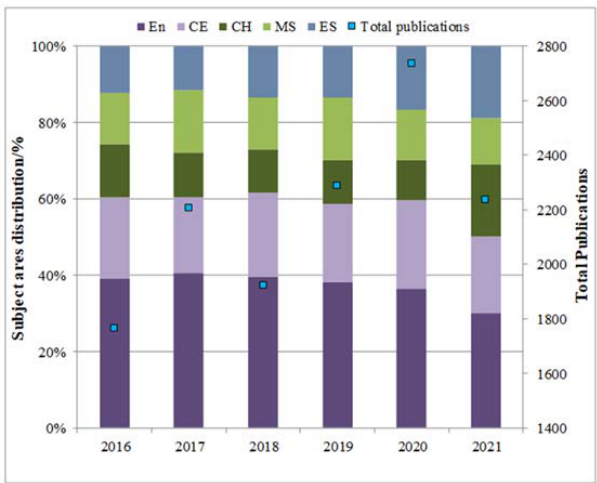
Figure 2. Summary of publication from Scopus for hydrogen generation by subject areas, where En refers to energy, CE refers to chemical engineering, CH refers to chemistry, MS refers to material science, and ES refers to environmental sciences.